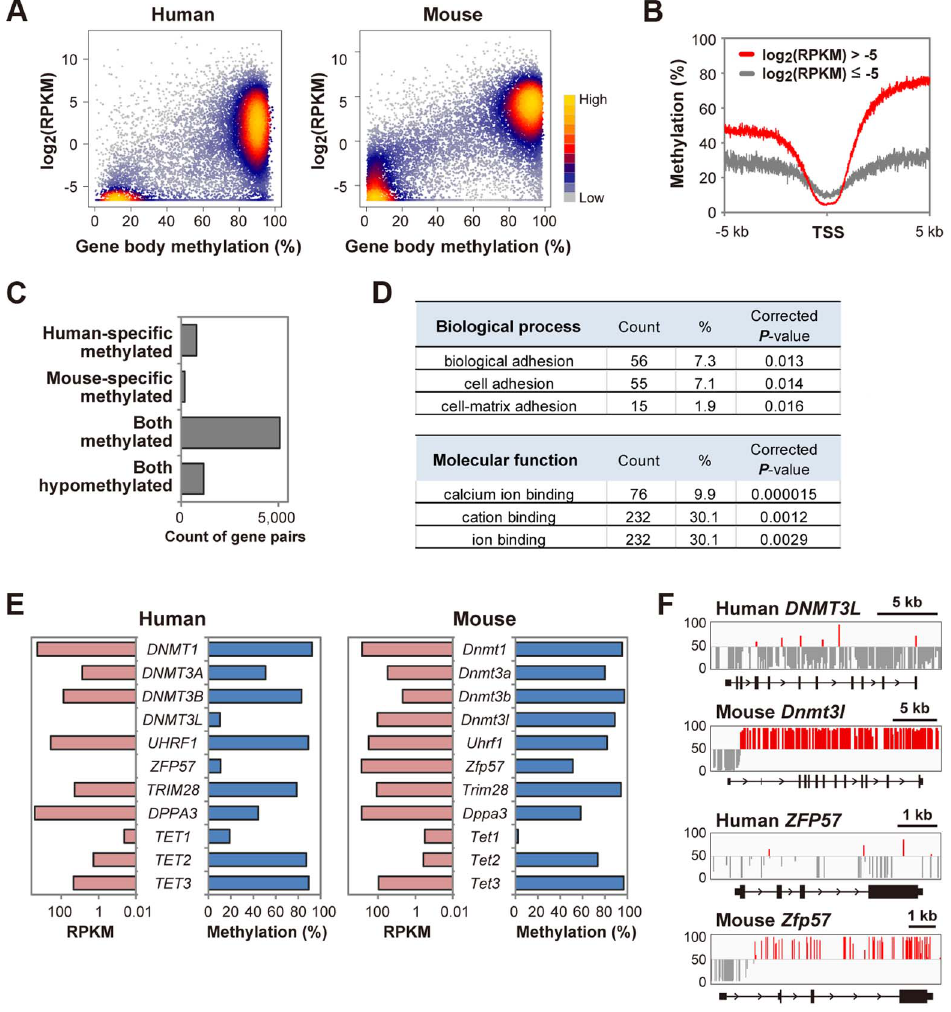
Fig. 3. A bimodal gene body methylation pattern associated with transcription in human oocytes. A, A density scatterplot of gene body methylation levels and transcription levels [43] in human oocytes. The data of mouse oocytes [5,11] are also shown for comparison. Only genes longer than 5 kb were analyzed. For genes with RPKM less than 0.01, RPKM was set as 0.01. The density is color-coded as indicated. B, Mean methylation levels within 5 kb of transcription start sites (TSS) in human oocytes. Genes ( . 5 kb) were classified into two groups (log 2 (RPKM) .2 5 and #2 5). Methylation levels were smoothed using 5 bp non-overlapping sliding windows. C, Conservation of gene body methylation levels between human and mouse oocytes. 783 and 188 genes showed human-specific and mouse-specific gene body hypermethylation, respectively. 5076 and 1151 genes were hypermethylated and hypomethylated in both types of oocytes, respectively. The raw data are shown in S2 Table. D, GO analysis of 783 genes with human-specific gene body hypermethylation. The top three GO terms (biological process and molecular function) are indicated with gene counts, the proportion (%) and BH-corrected P -values. No GO term was enriched in genes with mouse-specific gene body hypermethylation. E, Gene body methylation levels and transcription levels of DNA methylation regulators in human and mouse oocytes. DNMT3L and ZFP57 showed gene body hypomethylation and were not expressed (RPKM , 0.01) in human oocytes. DNMT3B (RPKM=76.0) showed 10-fold higher expression than DNMT3A (RPKM=7.6) in human oocytes. In contrast, Dnmt3b (RPKM=4.9) showed , 6-fold lower expression than Dnmt3a (RPKM=30.6) in mouse oocytes. F, Methylation patterns at human DNMT3L and ZFP57 loci and mouse Dnmt3l and Zfp57 loci. The vertical line indicates the methylation level (%) and the baseline is set at 50% to highlight unmethylated CpGs. CpGs with . 50% and , 50% methylation are shown in red and grey, respectively.